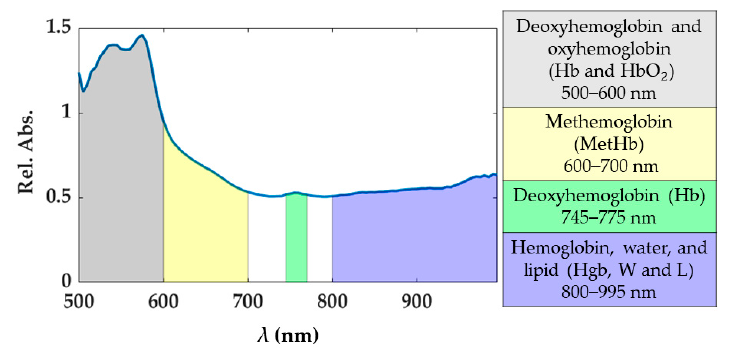
Figure 2. Spectral ranges considered for the study. These spectral ranges are associated with tissue chromophores.